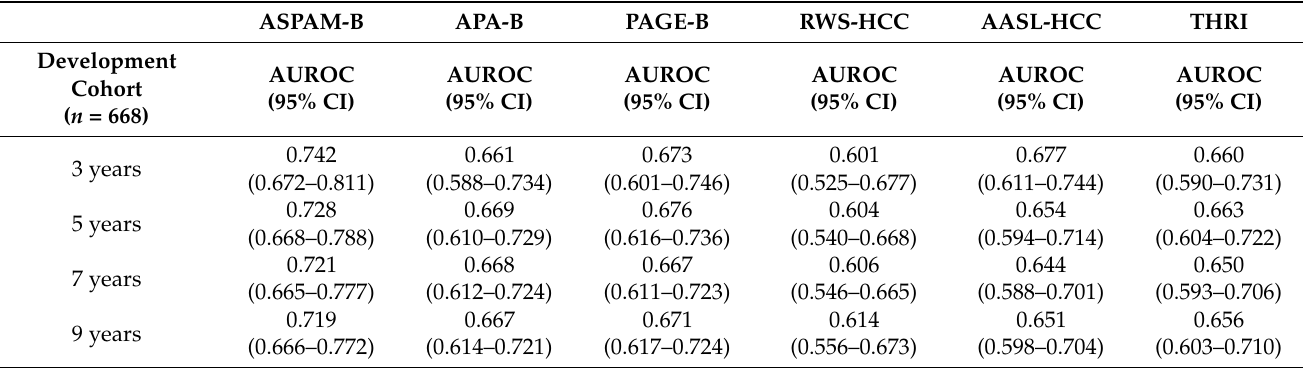
Table 4. The values of AUROCs for predicting hepatocellular carcinoma according to different risk models.